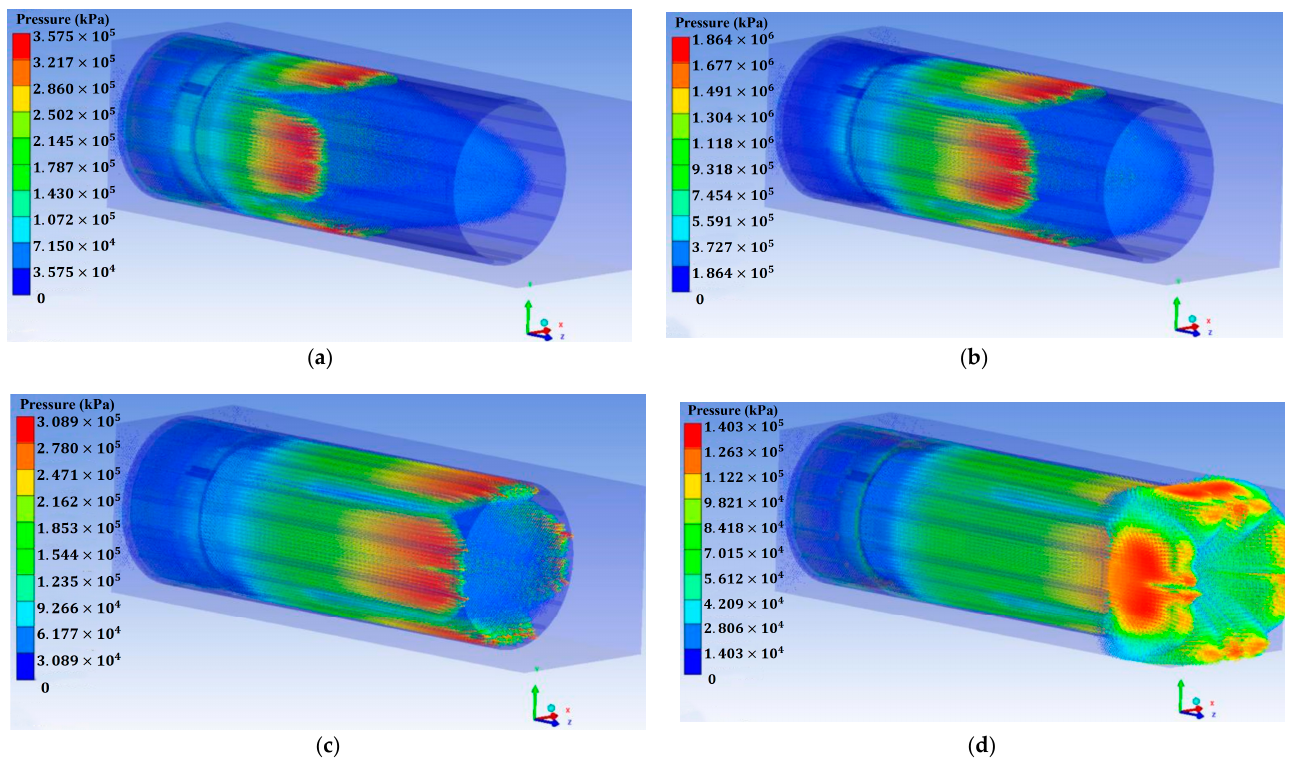
Figure 7. Stress contours in explosion airflow arc quenching. ( a ) Stress contours at t = 0.029 ms; ( b ) Stress contours at t = 0.041 ms; ( c ) Stress contours at t = 0.057 ms; ( d ) Stress contours at t = 0.08